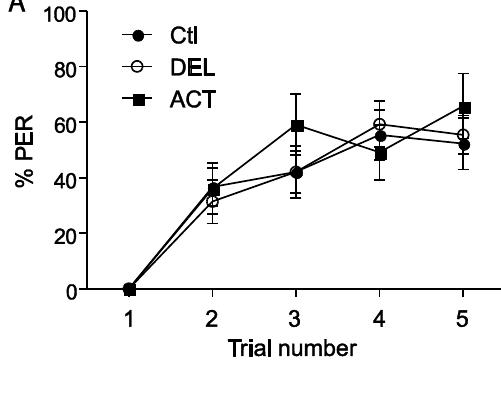
Figure 3. Retrieval responsiveness of honey bees when insecticides are applied 24 h before learning sessions. ( A , B ) bees treated with 10 ng/bee or 100 ng/bee of ACT or DEL, respectively. Data are expressed as the percentage of PER performance to antennal stimulation with 40% sucrose. Significant results are indicated by * p < 0.05. Each group represents n = 90 bees. Bars represent standard errors. Acetamiprid (ACT), deltamethrin (DEL), and control groups